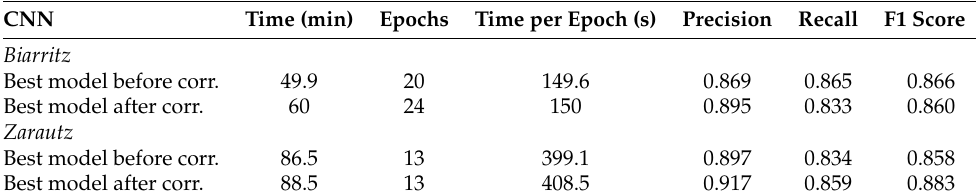
Table 3. Classification results after correcting the misclassification in the test and validation sets.